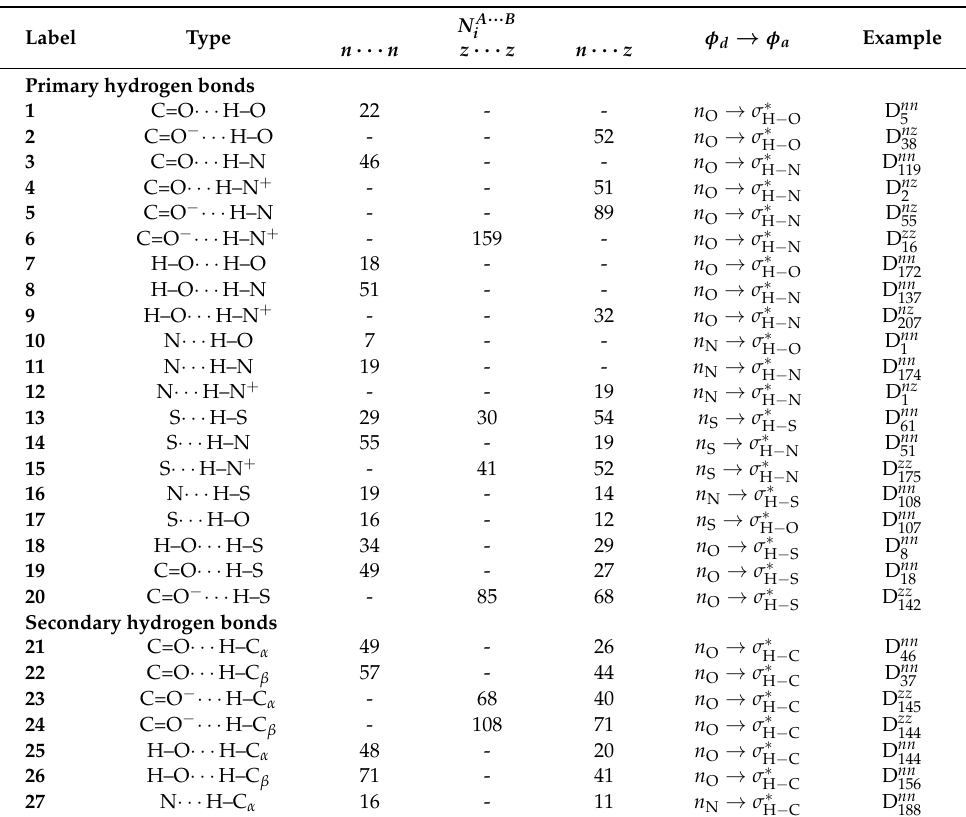
Table 3. Properties of the 20 types of primary hydrogen bonds, 10 types of secondary hydrogen bonds, and 12 types of dihydrogen bonds stabilizing the cysteine dimers. N A ··· B times that the interaction appears in the corresponding type of dimers. φ d , φ a are the charge donor and acceptor orbitals as identified from NBO. An example of a dimer containing each particular interaction is given in the rightmost